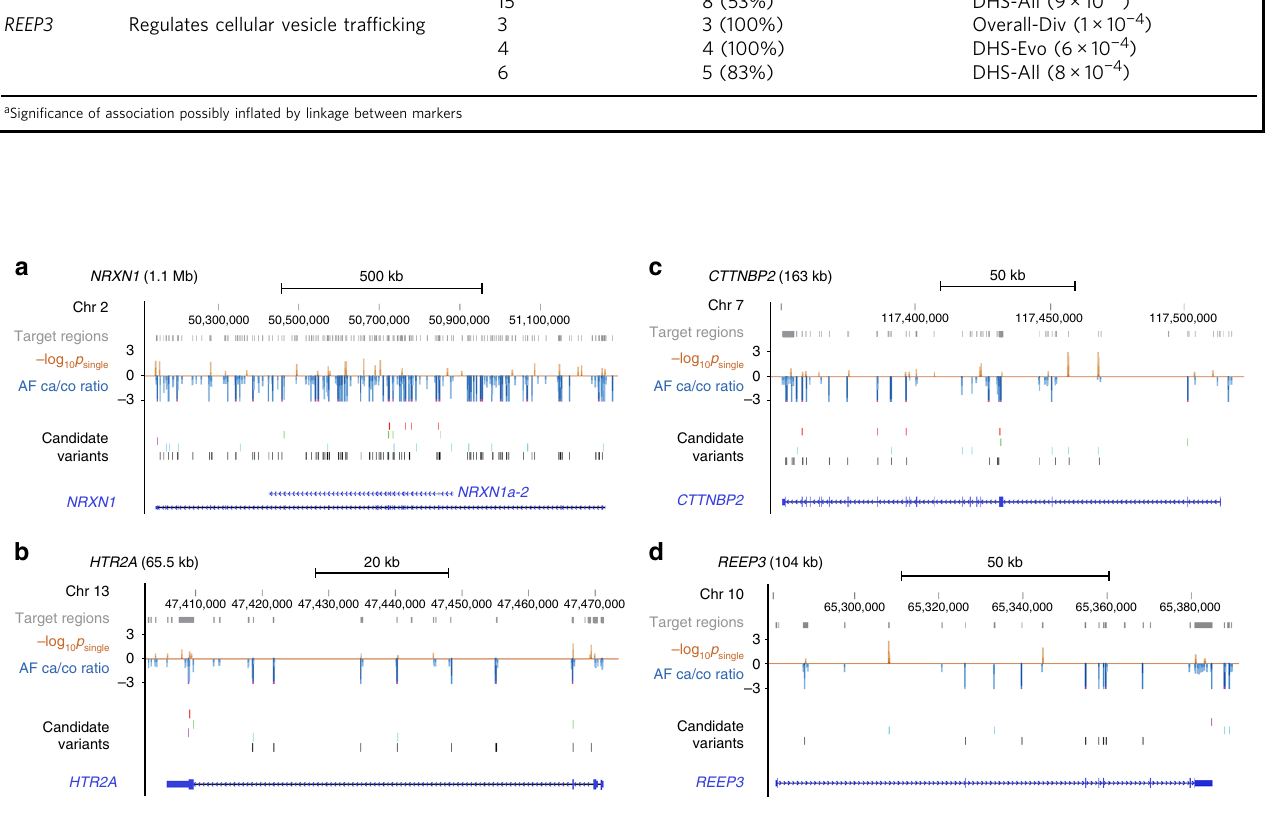
Fig. 2 Targeted-sequencing detects both coding and regulatory candidate variants in the four top-scoring genes a NRXN1 b HTR2A c CTTNBP2 and d REEP3 . Sequenced “ Target regions ” are shown as gray boxes above the red “– log 10 p single ” track displaying the association p -values for all detected variants and the blue “ AF ca/co ratio ” track showing the ratio of OCD AF over control AF. “ Candidate variants ” are annotated as missense ( red ), synonymous ( green ), untranslated ( purple ), DHS variants ( blue ), or unannotated ( black ). Lastly, the gene is shown as a horizontal blue line with exons ( solid boxes ) and arrows indicating direction of transcription. The highest scoring isoform of NRXN1 , NRXN1a-2 , is shown in ( a